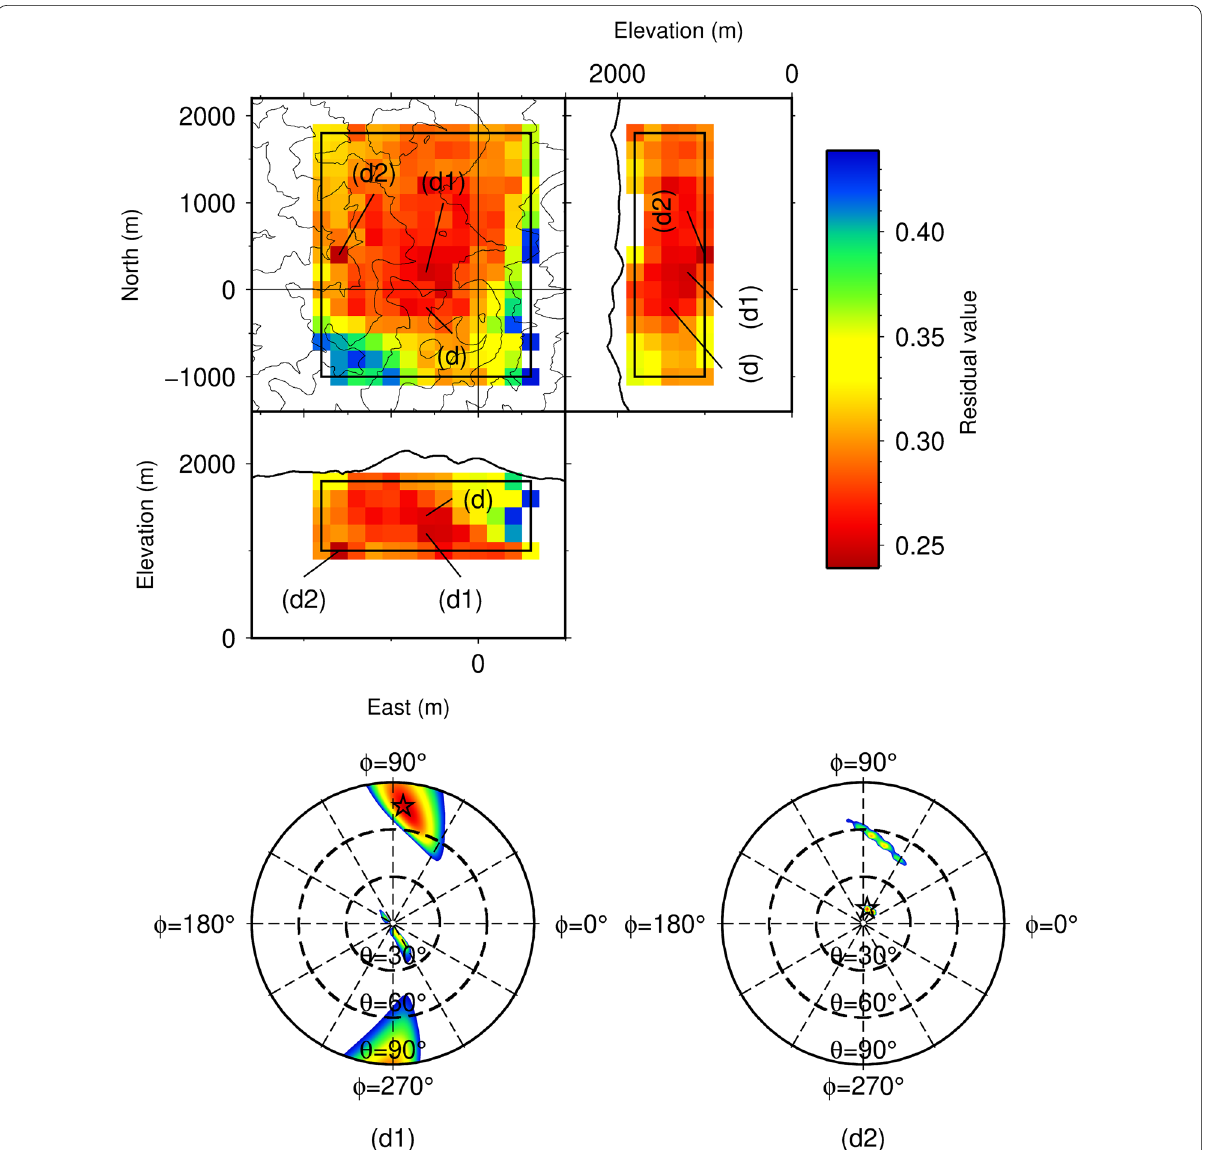
Fig. 11 Spatial distribution and crack orientation dependence of the residuals between the observed and synthetic waveforms obtained by second grid search about the candidate ( d ). The locations of candidates ( d ), ( d1 ), and ( d2 ) are indicated by straight lines on the plane map. See Fig. 5 for details concerning the plotting